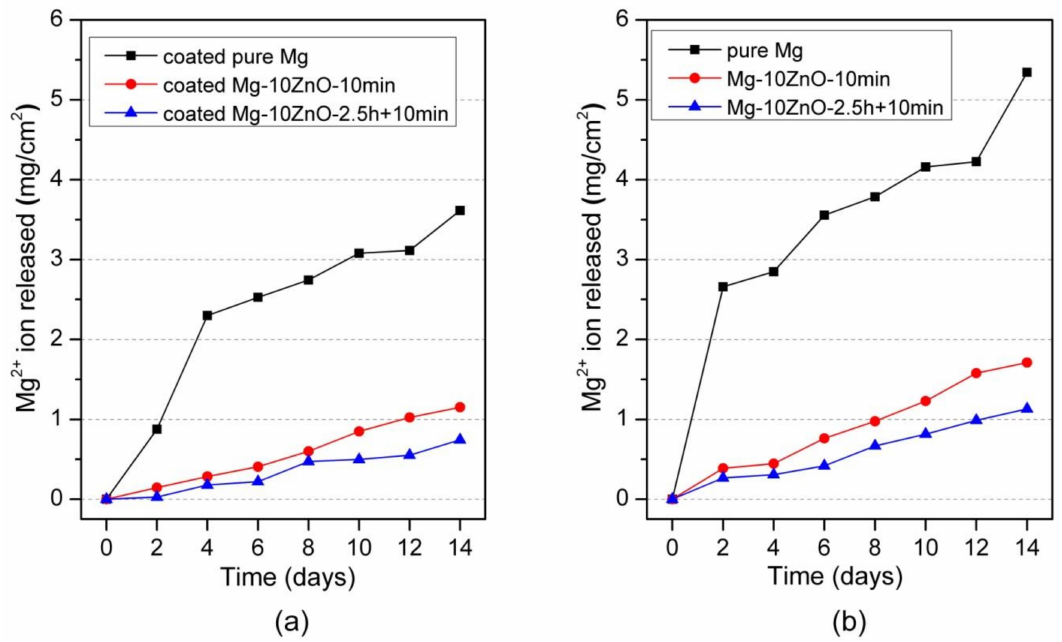
Figure 6. Mg 2 + ion release in Hanks’ solution during immersion test, ( a ) the result of HAp coated samples in this study, and ( b ) the result of uncoated samples was cited from [12].